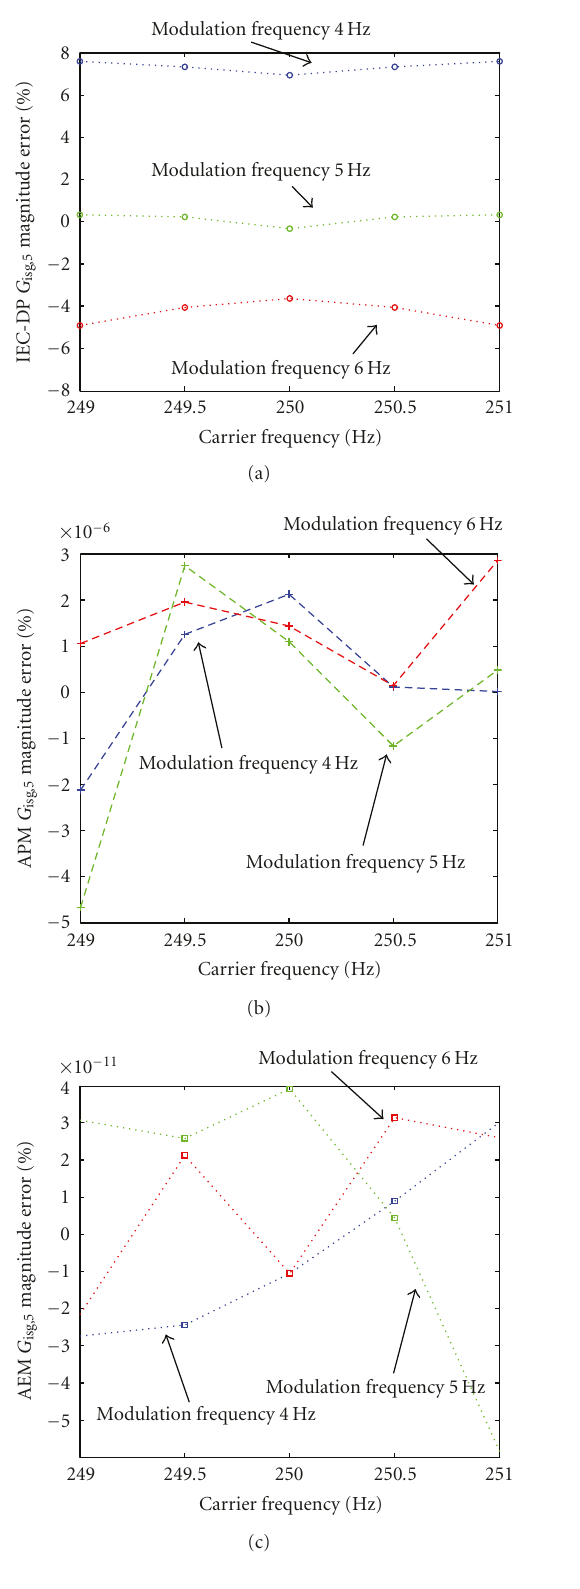
Figure 12: Case study 4: harmonic subgroup G sg,5 magnitude error (in %) versus the carrier frequency for three modulation frequen- cies: (a) IEC-DP (dotted line ◦ ), (b) APM (dotted line +) and (c) AEM (dotted line (cid:3) ).